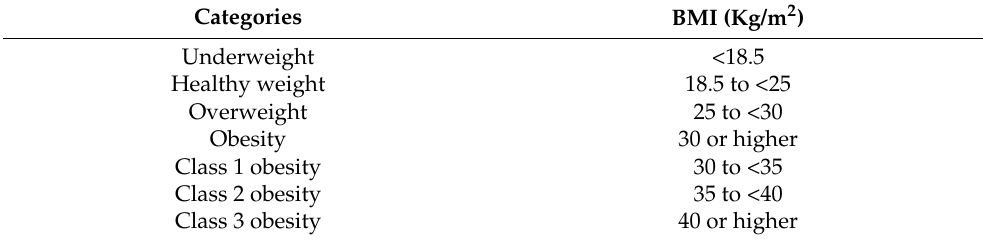
Table 1. Weight categories according to adult body mass